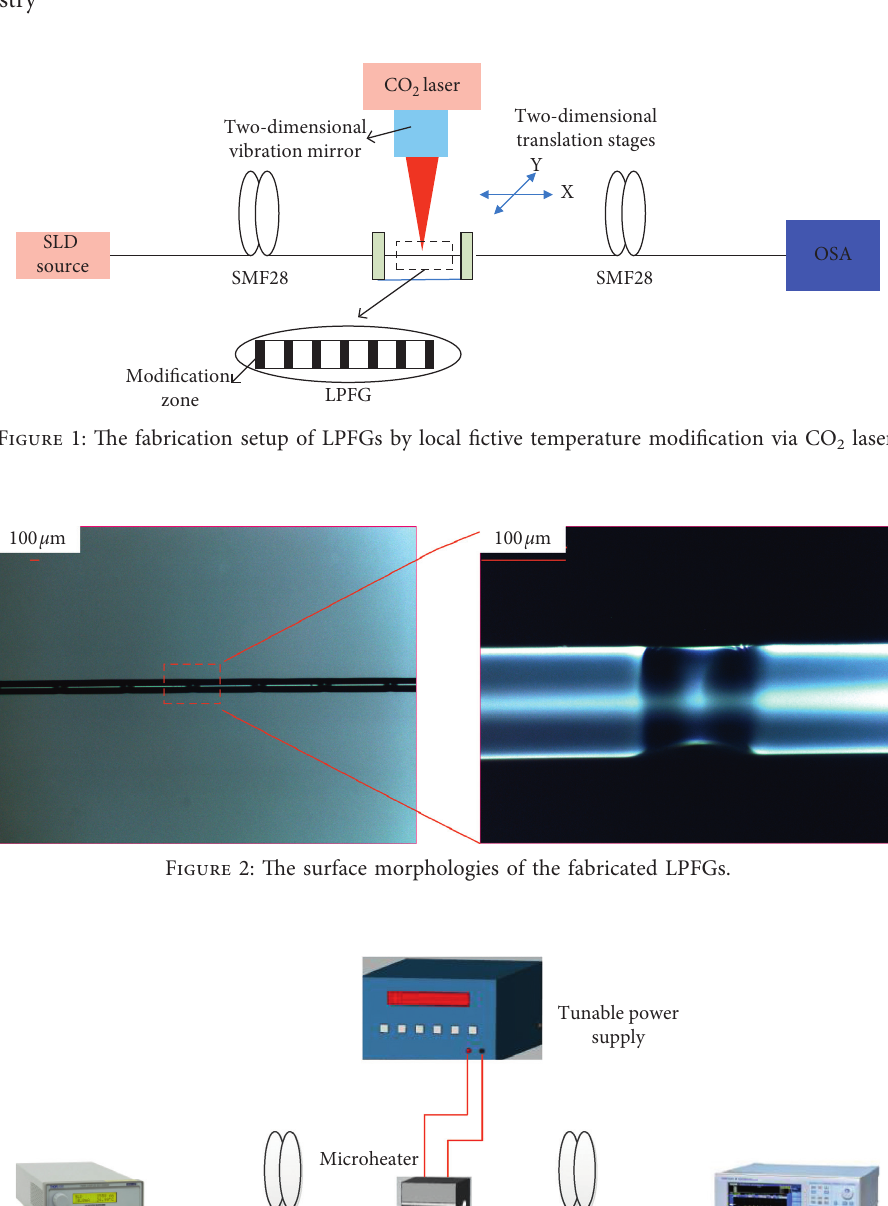
Figure 3: The schematic diagram of the temperature sensing experimental setup.